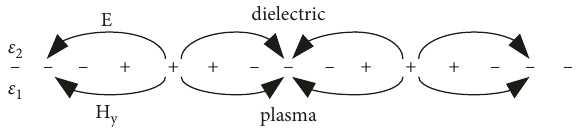
Figure 1: Schematic diagram of surface plasmon propagation on metal and dielectric surfaces.